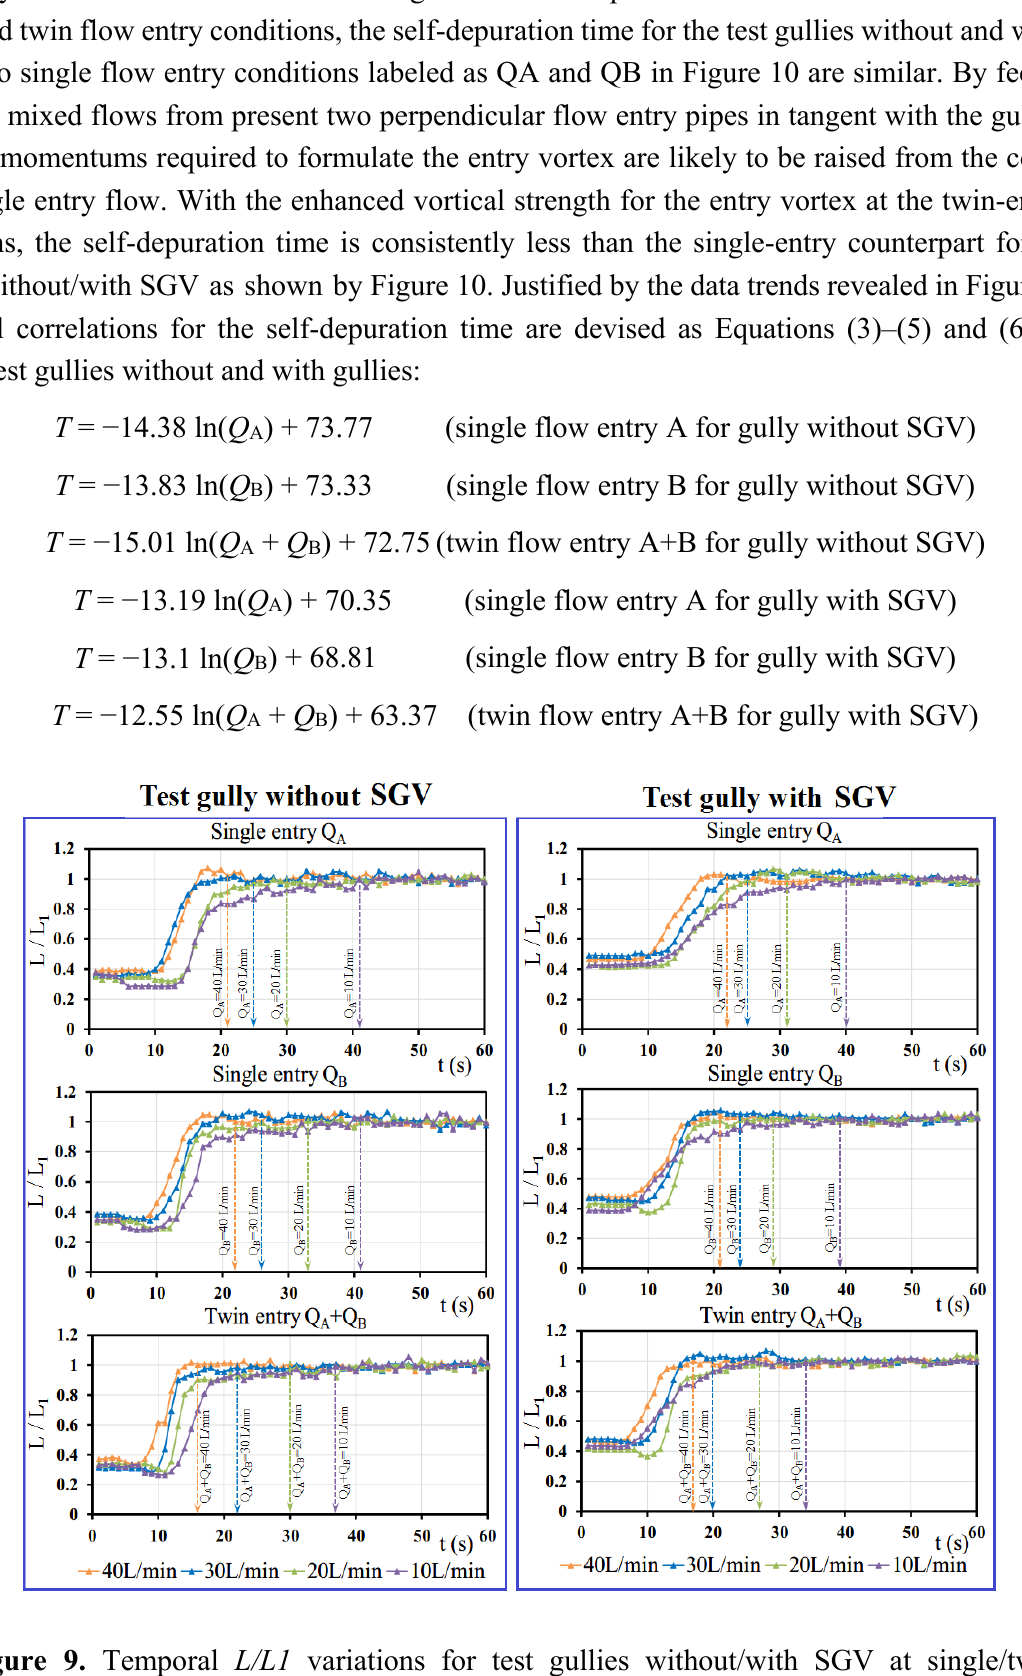
Figure 9. Temporal L/L1 variations for test gullies without/with SGV at single/twin entry